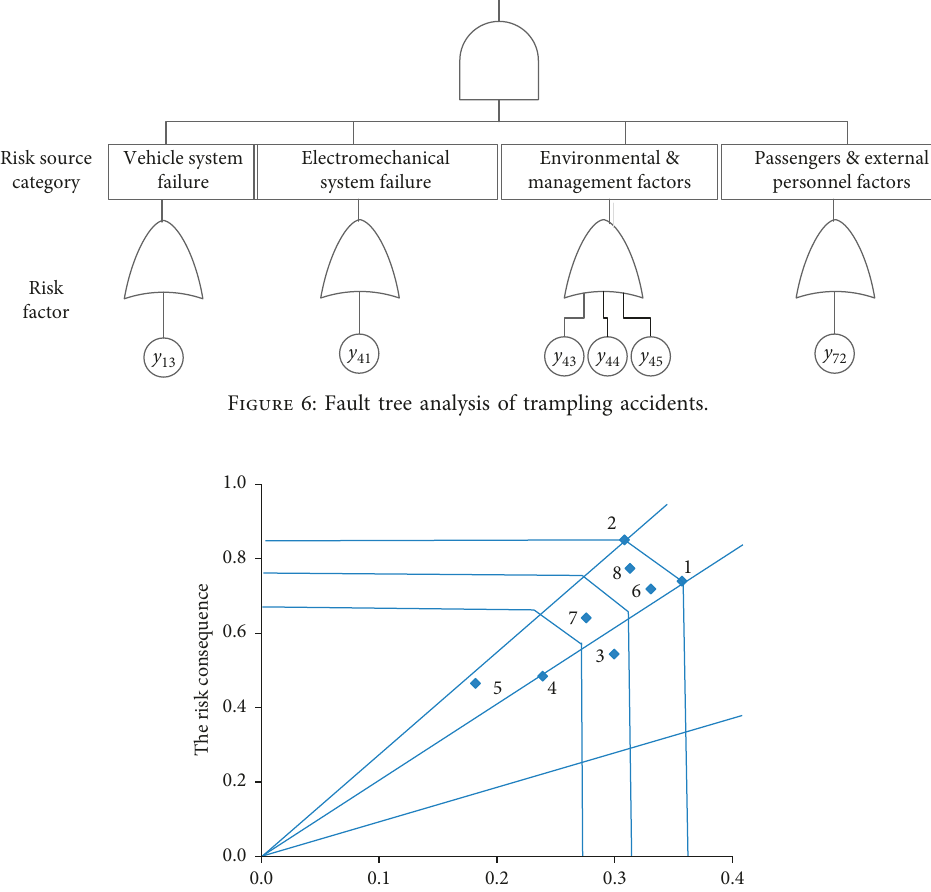
Figure 7: Surface distribution of risk area of